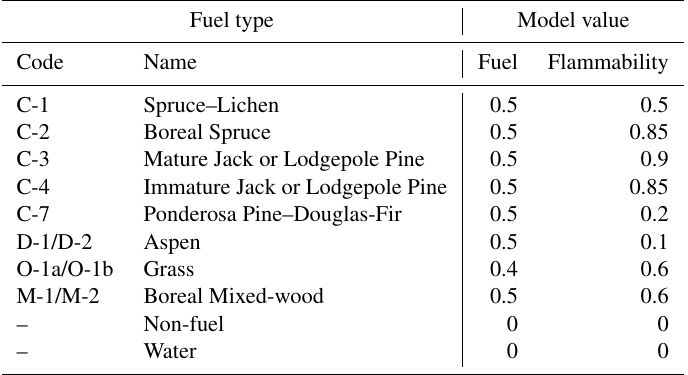
Table A1. Fuel type and variable